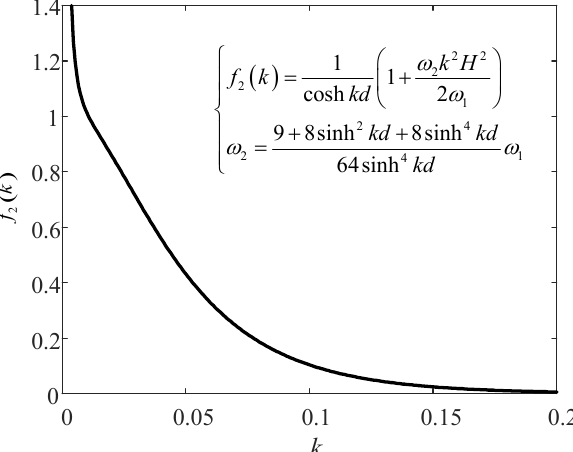
Figure 7. The normalized first-order pore pressure f 2 ( k ), varying with wave number k.